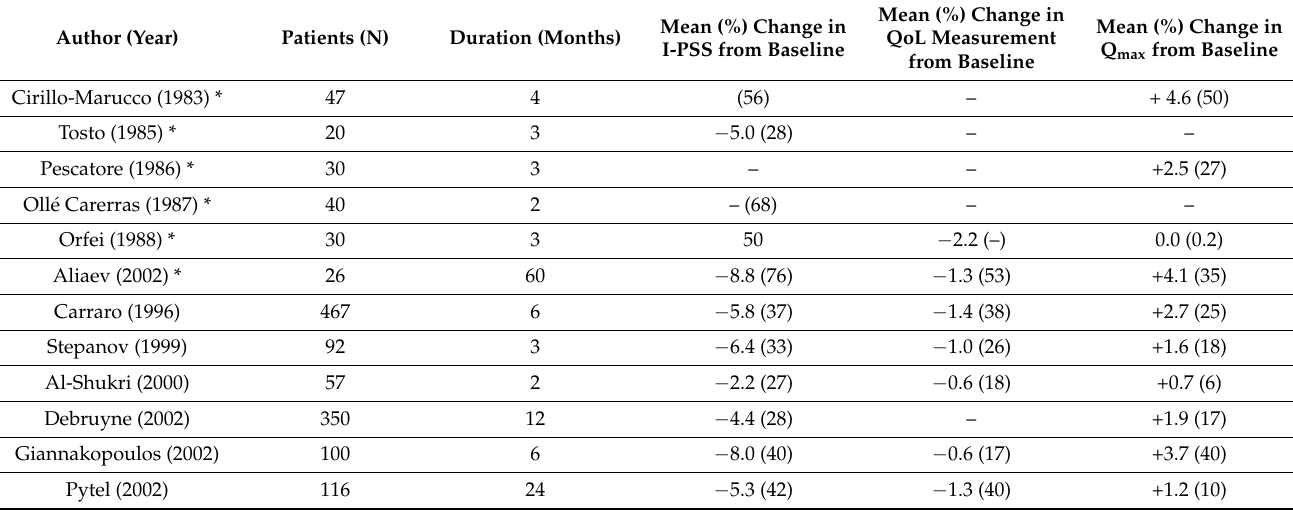
Table 4. Summary of global literature examining the efficacy of Permixon